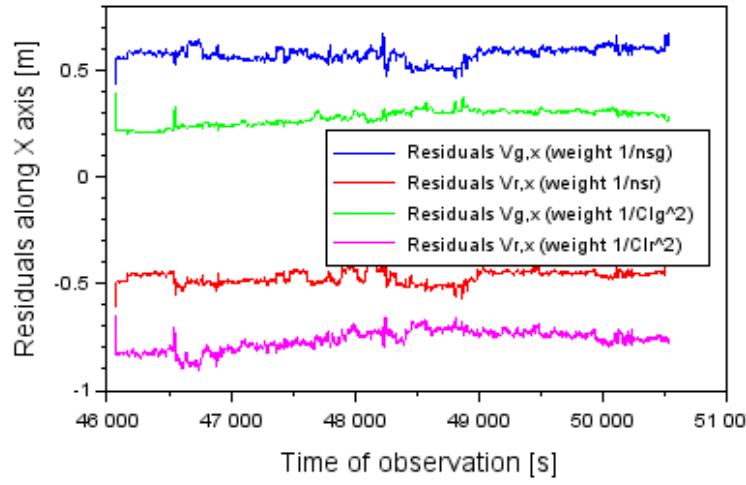
Figure 5. Residuals ( V g , x ; V r , x ) along the X -axis.